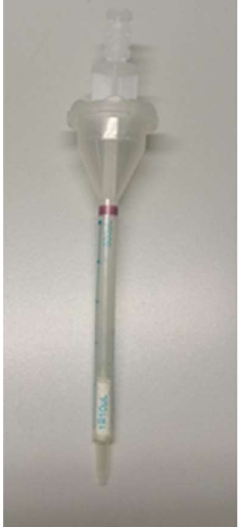
Figure 4. Eppendorf syringe packed with CYPHOS.